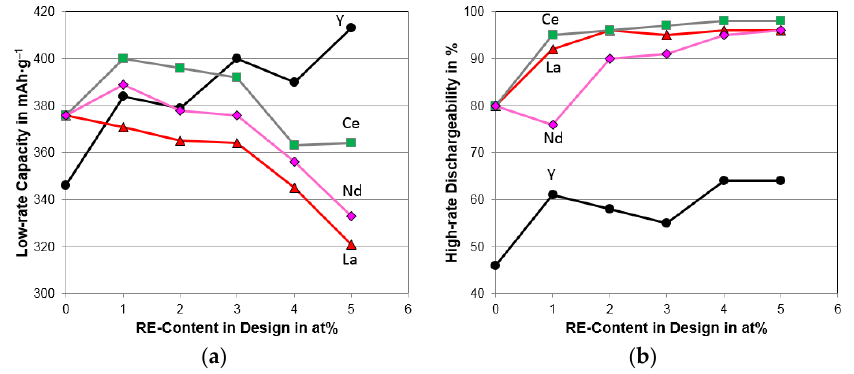
Figure 11. Evolutions of ( a ) low-rate capacity and ( b ) HRD at the third cycle with increasing RE-content in the design. Table 6. Summary of electrochemical half-cell and magnetic measurements, including the capacities at the third cycle, HRD at the third cycle, number of cycles needed to achieve 92% HRD, bulk diffusion coefficient, surface exchange current, results from AC impedance measurements, saturated magnetic susceptibility, and applied field at half of the saturated magnetic